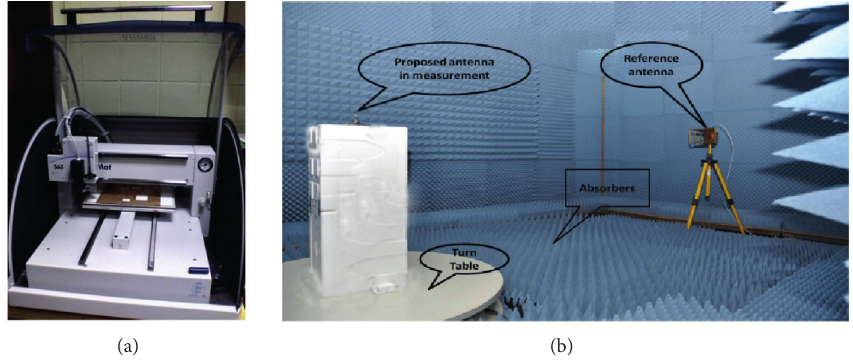
Figure 12: (a) LPKF machine (S63) and (b) anechoic